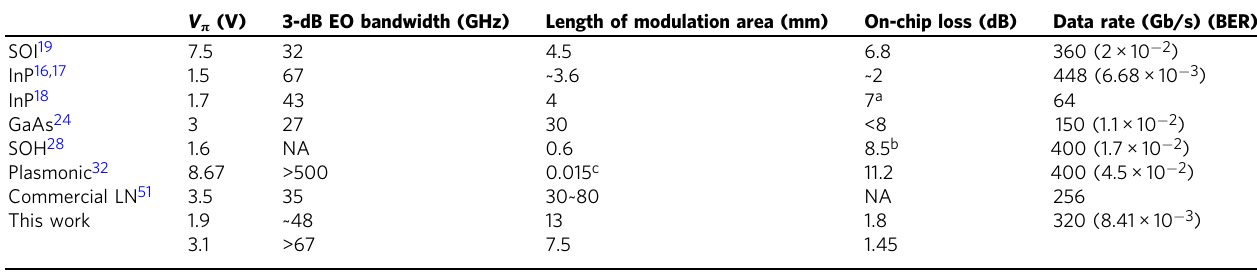
Table 1 Comparison of several performance metrics of IQ